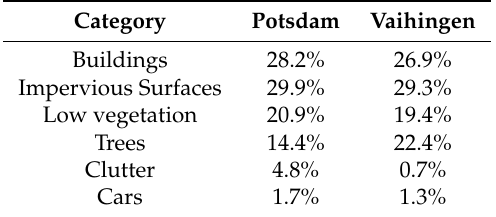
Table 1. The distribution of pixels among